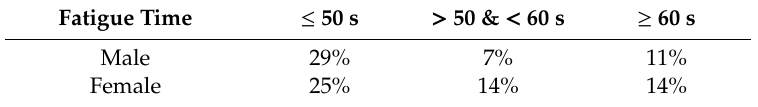
Table 8. Distribution (%) of the volunteers according to the time they started feeling muscle fatigue. Fatigue Time ≤ 50 s > 50 & < 60 s ≥ 60 s